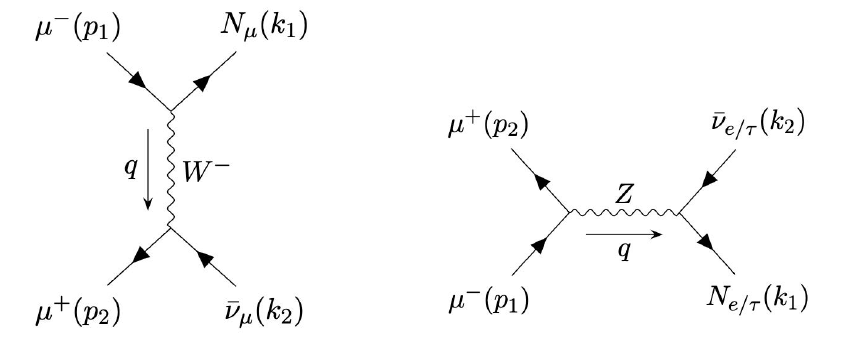
Figure 1 . The Feynman diagrams for µ + µ − → N ‘ + ¯ ν ‘ . The left panel is for N µ and the right panel is for N . e/τ